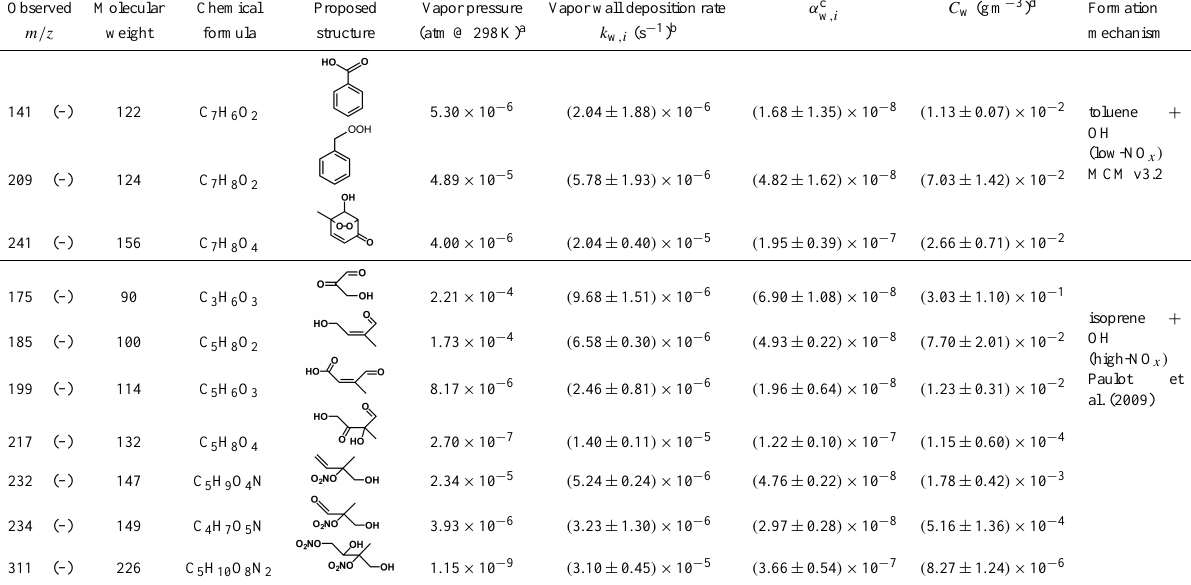
a Vapor pressures are estimated from the average of predictions from the two group contribution methods, “SIMPOL.1” (Pankow and Asher, 2008) and “EVAPORATION” (Compernolle et al., 2011). b The vapor wall deposition rate ( k w ,i ) is calculated by Eq. (22b). c The accommodation coefficient ( α w ,i ) is calculated via optimal fitting of Eq. (22b) to the CIMS measured vapor decay rate assuming first-order kinetics and irreversible gas–wall partitioning. d C w is calculated from the combination of Eqs. (16) and (17) as an equation set.